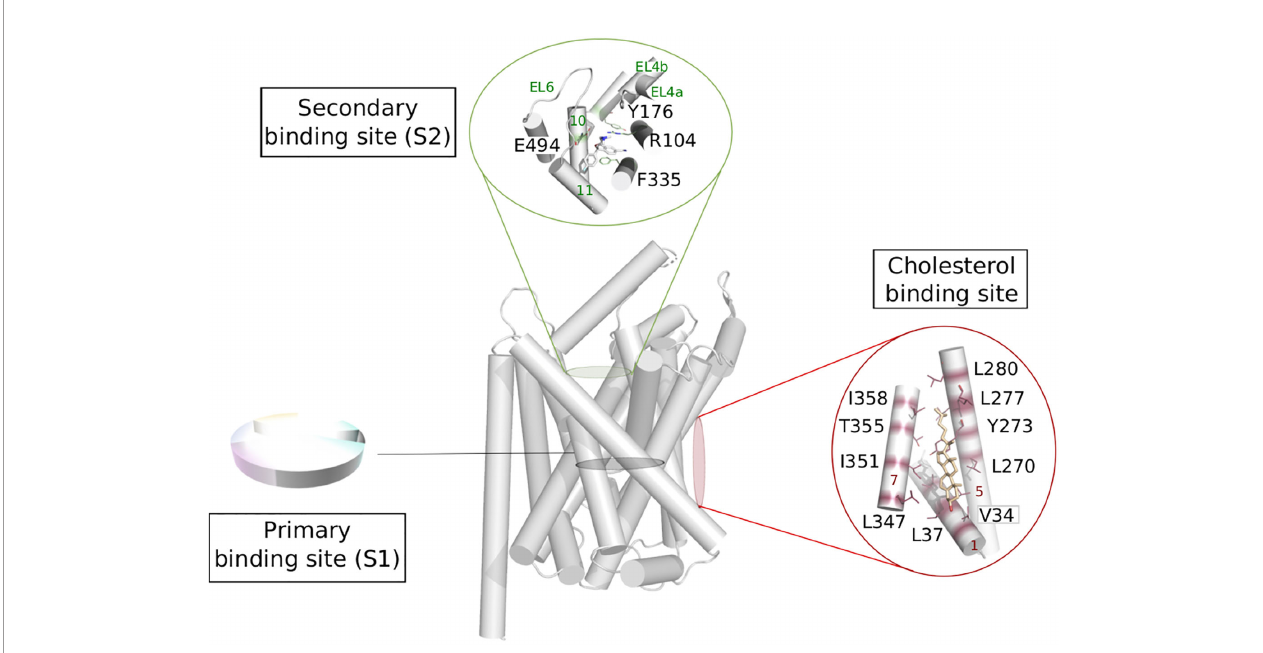
FIGURE 5 | Possible functional mapping of the LeuT fold. Building on the functional mapping of the binding site proposed in Figure 4 , we show here two additional area where functional mapping could be bene fi cial, i.e., on the secondary and cholesterol binding sites. The residues involved in binding are shown in sticks and labeled (hSERT numbering for the secondary site and dDAT numbering for the cholesterol binding site), the helices and loops are named on green and red on the secondary et cholesterol binding site, respectively. Expanded to the whole fold, a systematic annotation could help the identi fi cation of new sites that could be targeted in ligand